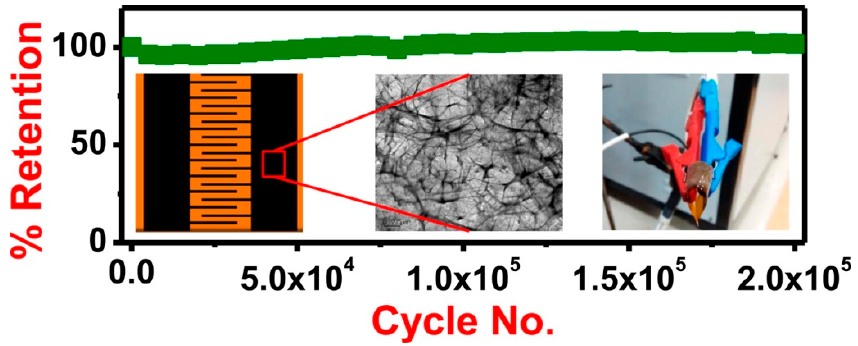
Figure 7. Graphical summary of structural and electrochemical properties for LIMDG electrode [106].